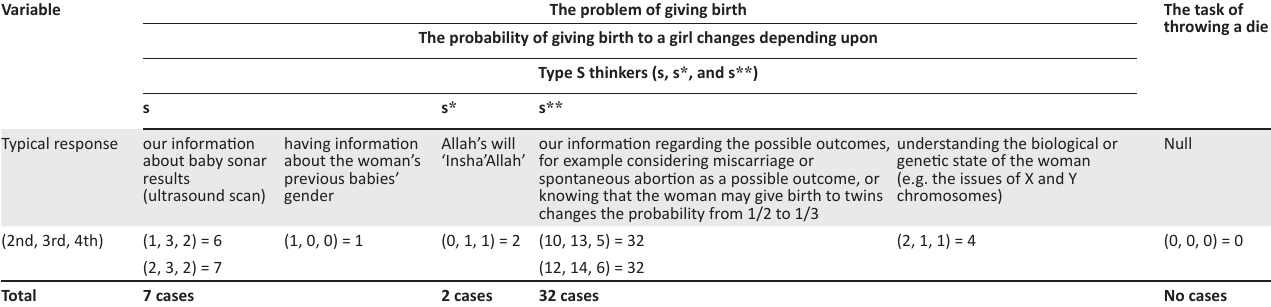
TABLE 4: Subjectively oriented thinkers (S = s, s * , and s ** reasoning).